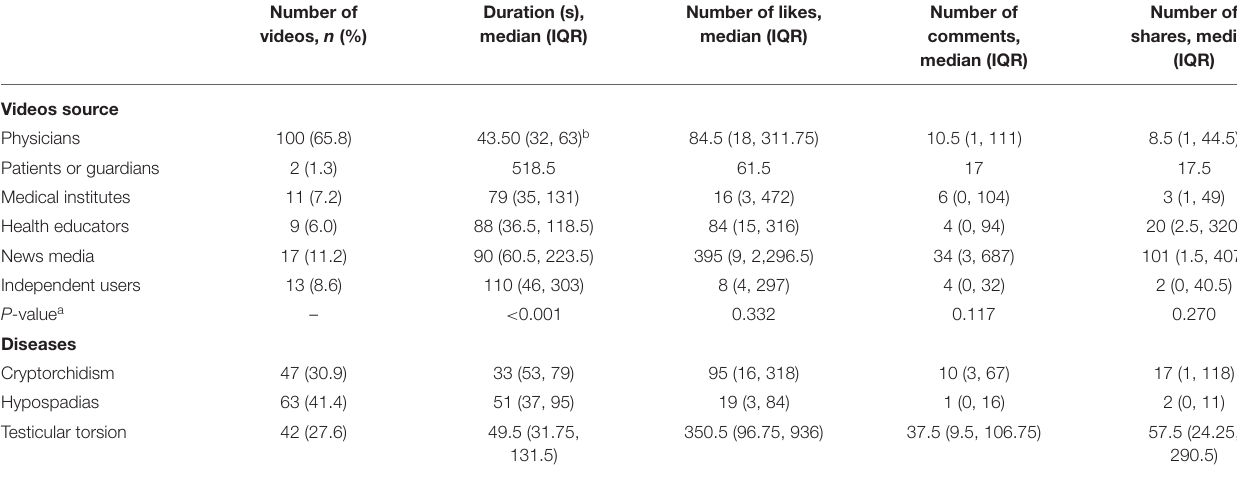
TABLE 2 | General features sorted by video source and